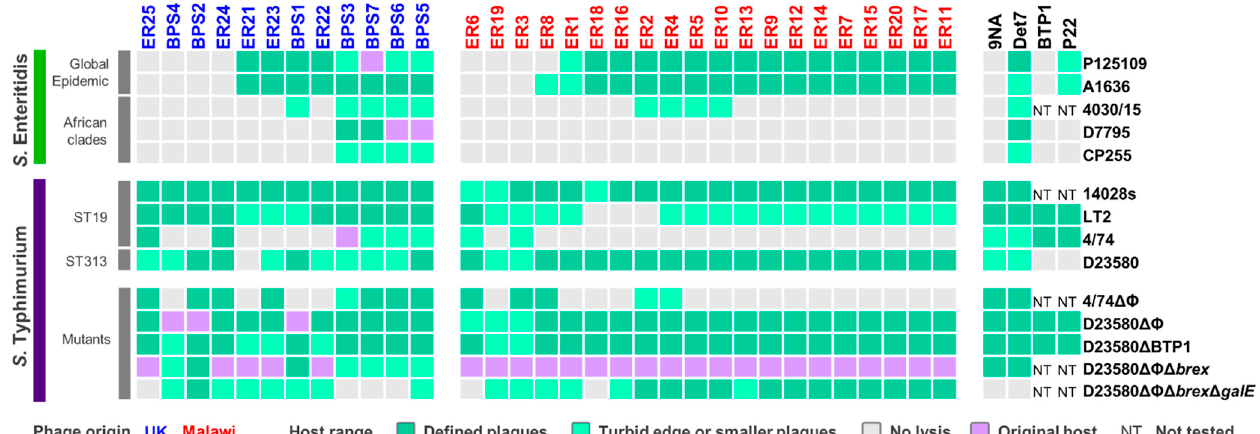
Figure 1. Host range of isolated phages. Host range analysis was determined by spot assay on S. Enteritidis or S. Typhimurium host strains, with phages isolated in the UK (blue) or Malawi (red). Reference phages are displayed in black. Host range of biological replicates was recorded as defined lysis (dark green), turbid edge or smaller plaques (light green), and no lysis (grey). Examples of the different lysis observed are shown in Figure S1. The original Salmonella host used for phage isolation is indicated in purple. NT: not tested.